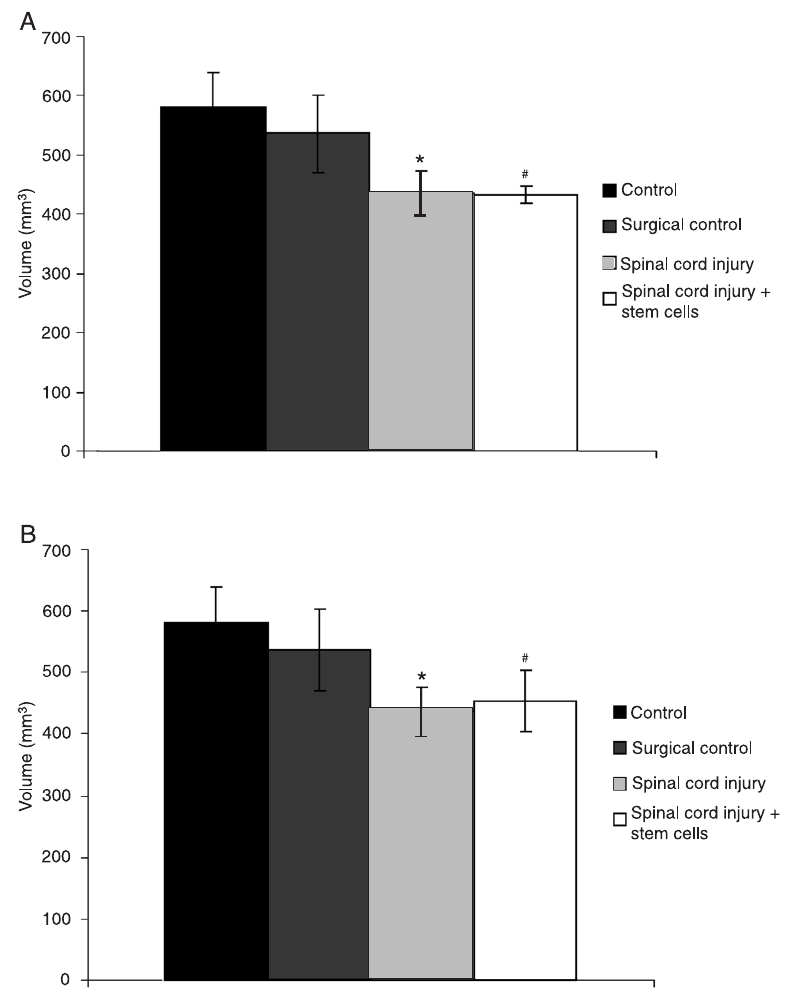
Figure 2. Volume of the thoracic spinal cord lesions of the group treated 1 h ( Panel A ) or 9 days ( Panel B ) after spinal cord injury. Data are reported as means ± SD for 5 rats in each group. *P ≤ 0.05, difference between the control groups and the spinal cord injured group (Mann-Whitney test). # P ≤ 0.05, difference between the control groups and treated group (Duncan